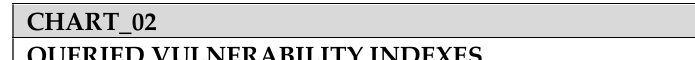
Figure 10. Simple query: presence of flue pipes and their degree of incidence on the vulnerability of the wall panel.